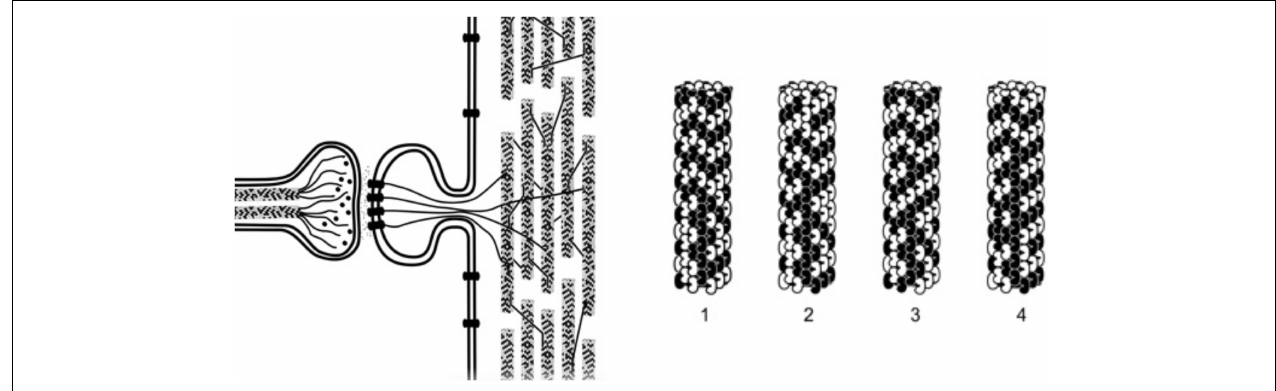
FIGURE 3 | Left: An axon forms a synapse with a. dendritic spine on a dendrite of another neuron, internal microtubules, actin and membrane proteins are shown. Dendritic microtubules are interrupted, and in mixed polarity arrays. Right: 4 steps in a microtubule automata processing information with binary states of tubulins (microtubule automata patterns on right taken from Rasmussen et al.,